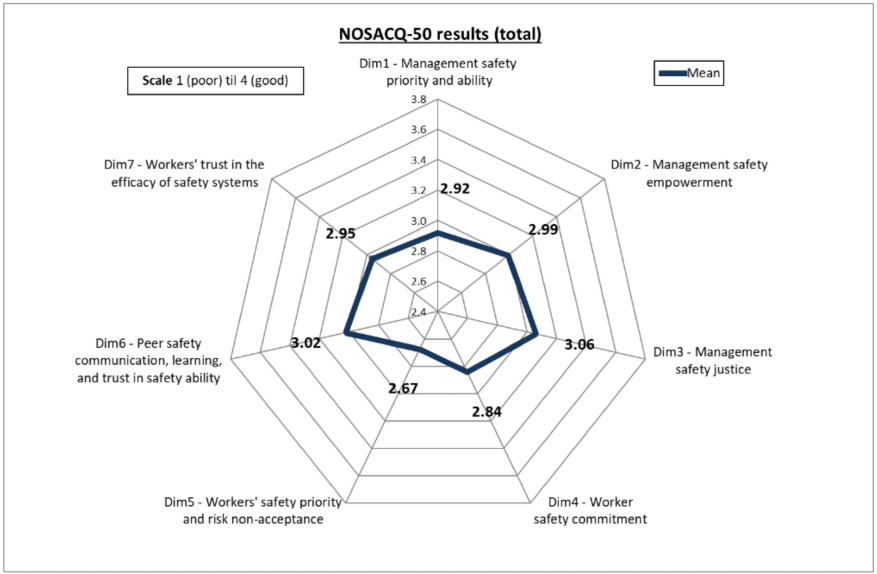
Figure 2. Results of the NOSACQ-50 questionnaire related to all the interviewed